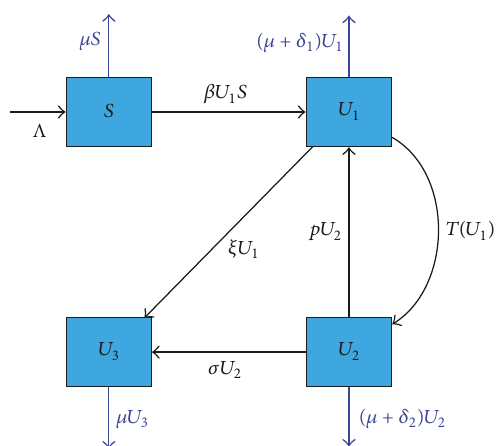
Figure 2: A heroin epidemic model with bilinear incidence rate and saturated treatment function. The blue solid arrows represent deaths due to either heroin or natural causes while the black solid arrows represent change of status from one compartment to